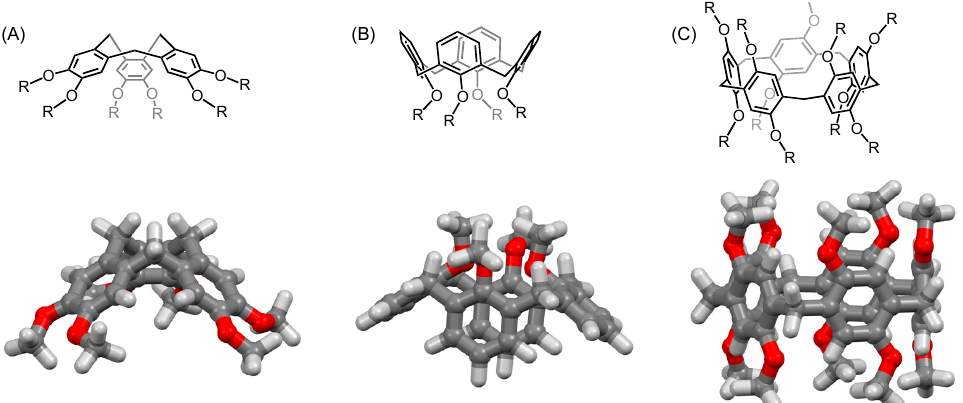
Figure 1. ( A ) Cyclotriveratrylene; ( B ) calix[4]arene; ( C ) pillar[5]arene. The calculated structures of the methoxy-substituted derivatives highlight the different conformations adopted by these mac- rocycles: cone-shape in the case of the CTV and the calix[4]arene, and tubular in the case of the pillar[5]arene.